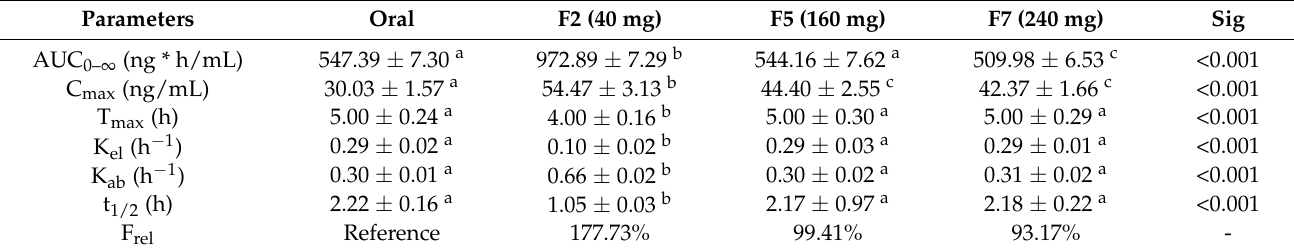
Table 4. Pharmacokinetic parameters among study